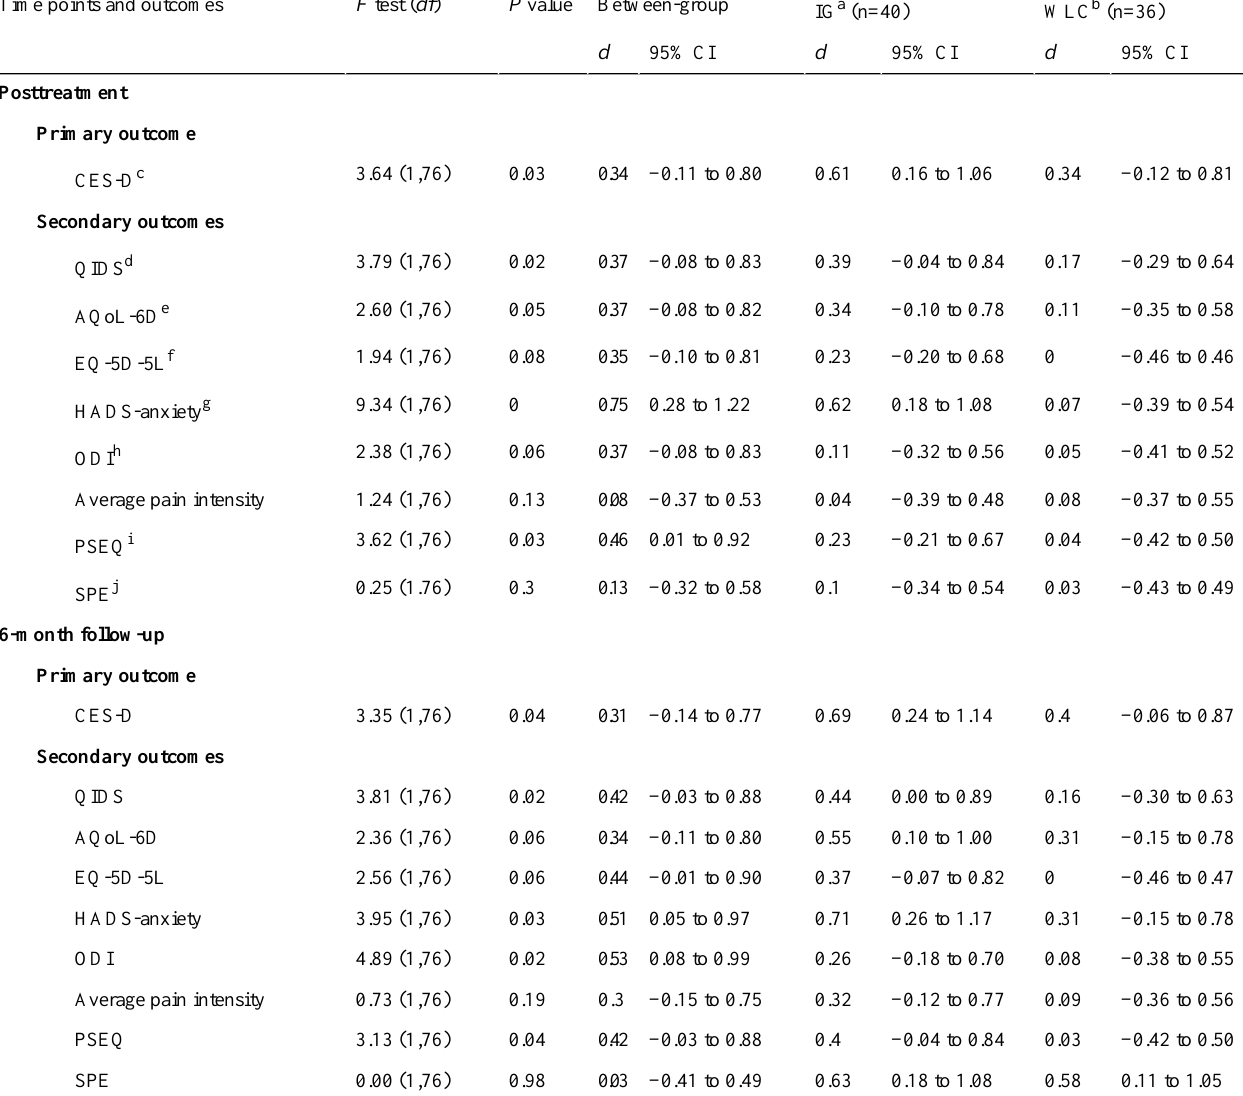
Table 6. Sensitivity analyses (last observation carried